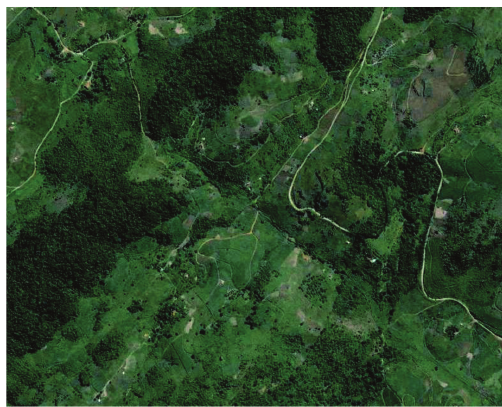
Figure 1: The Amaraj´ı landscape Pernambuco, Brazil, 2009, scale =